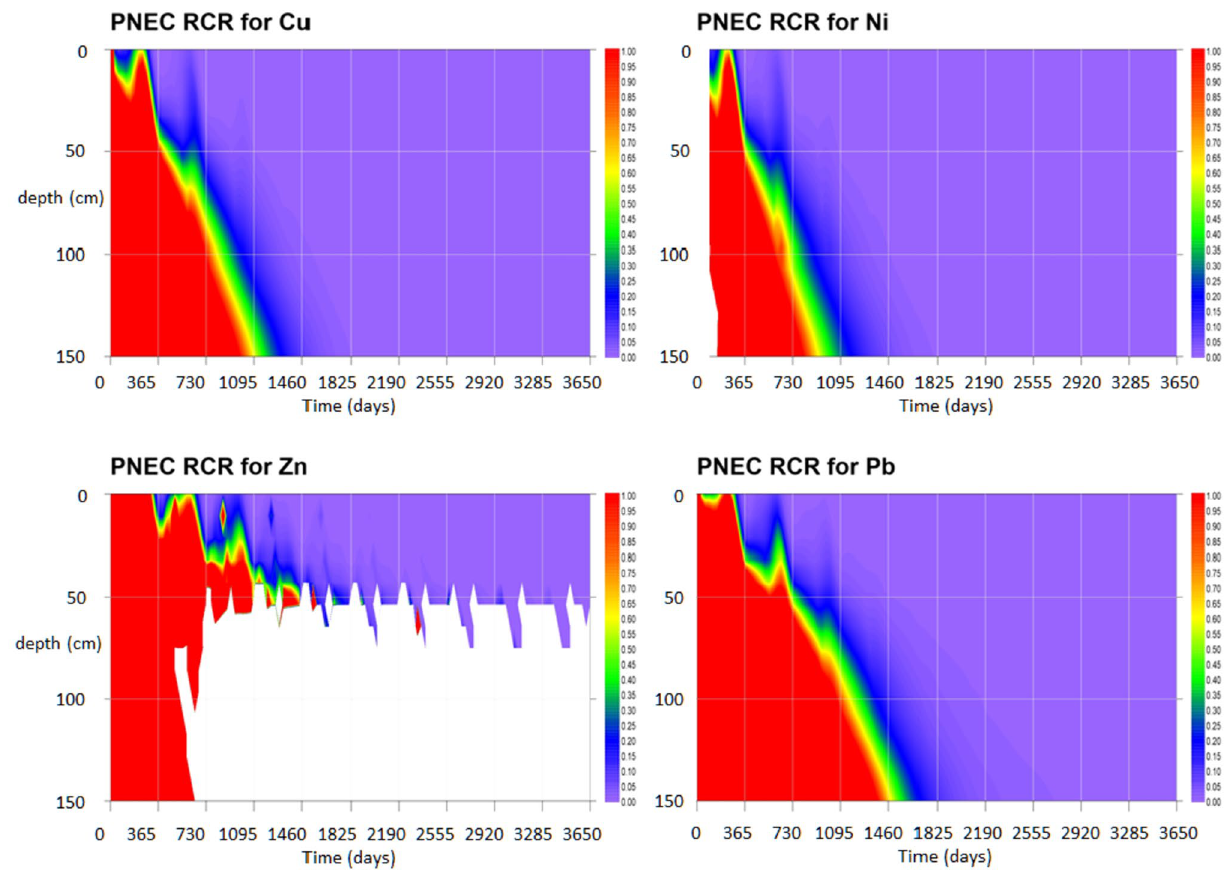
could not be calculated due to the models out of boundary condi- tions, the graph is